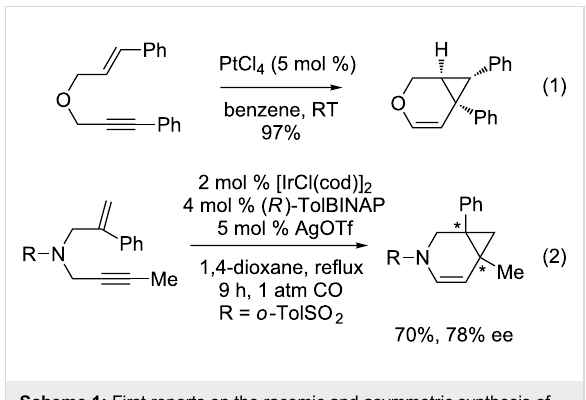
Table 1: Cycloisomerization reaction of nitrogen- and oxygen-linked 1,6-enynes 1a and 2a .